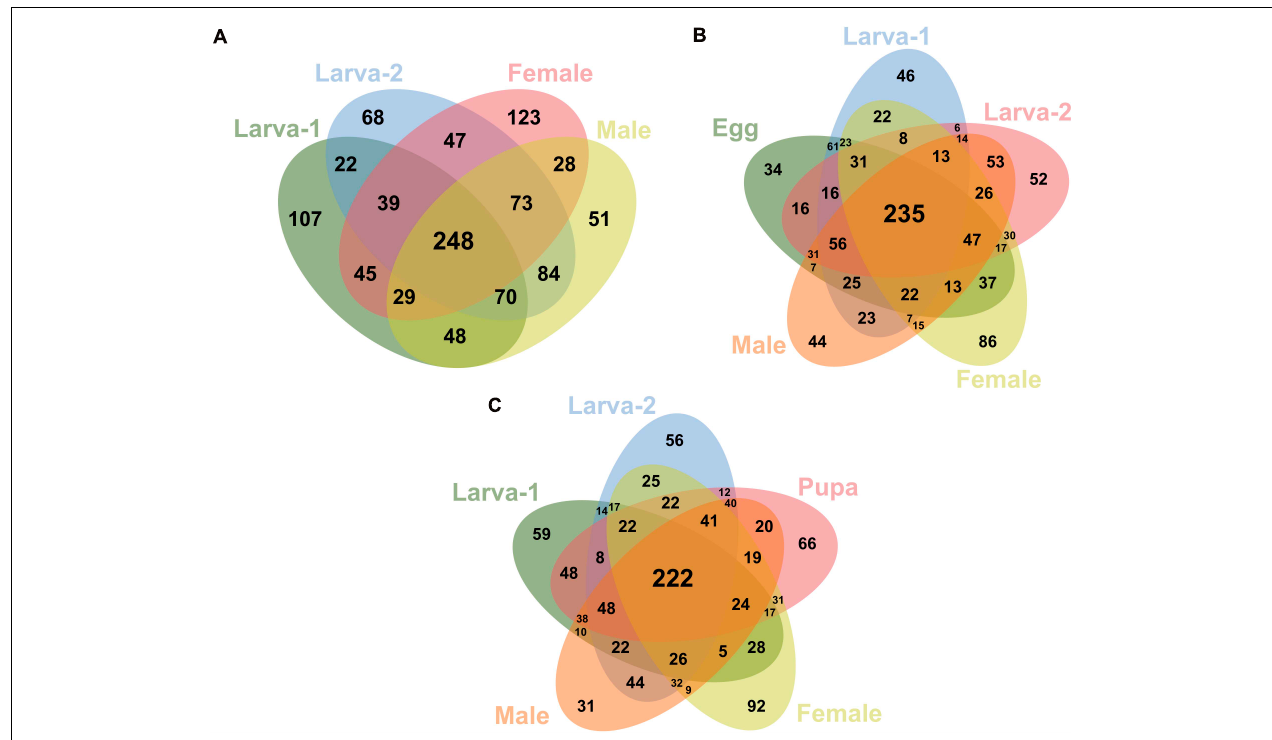
FIGURE 4 | Venn diagrams showing the shared/specific bacterial OTUs (at 99% similarity) between the different developmental stages of Hypothenemus hampei . Comparisons are shown for the feeding life stages (larva-1, larva-2, female and male) in (A) ; for the active-feeding life stages and egg in (B) ; and for the active-feeding life stages and pupa in (C)